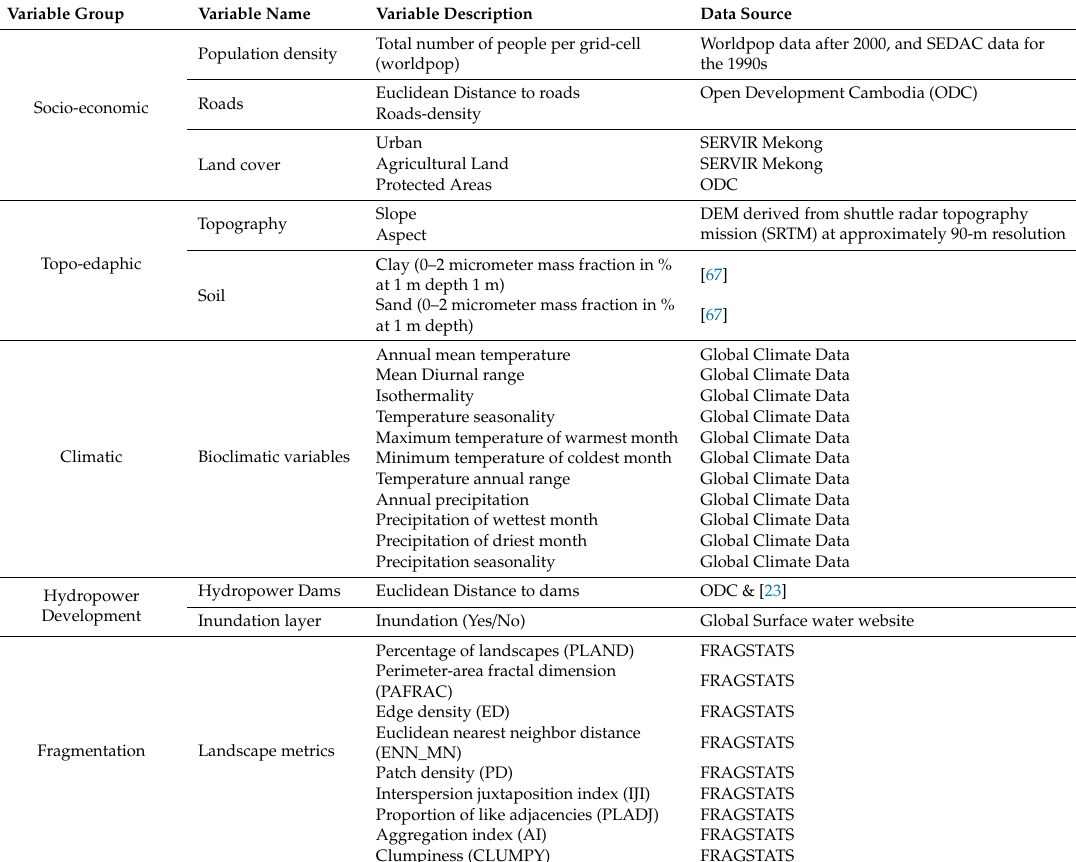
Table 1. Predictor variables, descriptions, rationale, and data